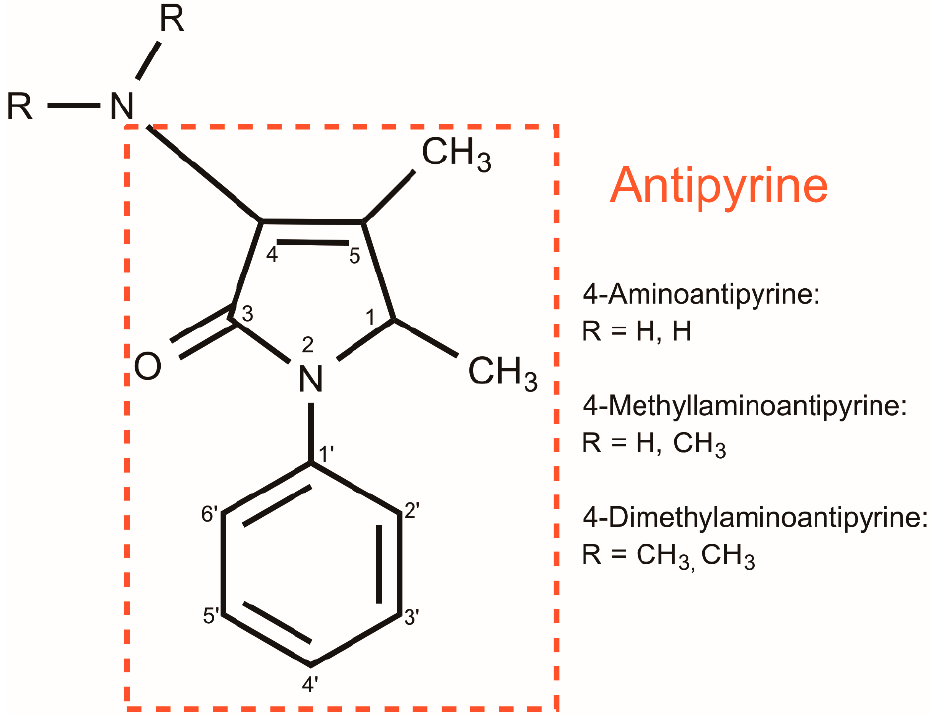
Figure 1. Structure of antipyrine and its derivatives.